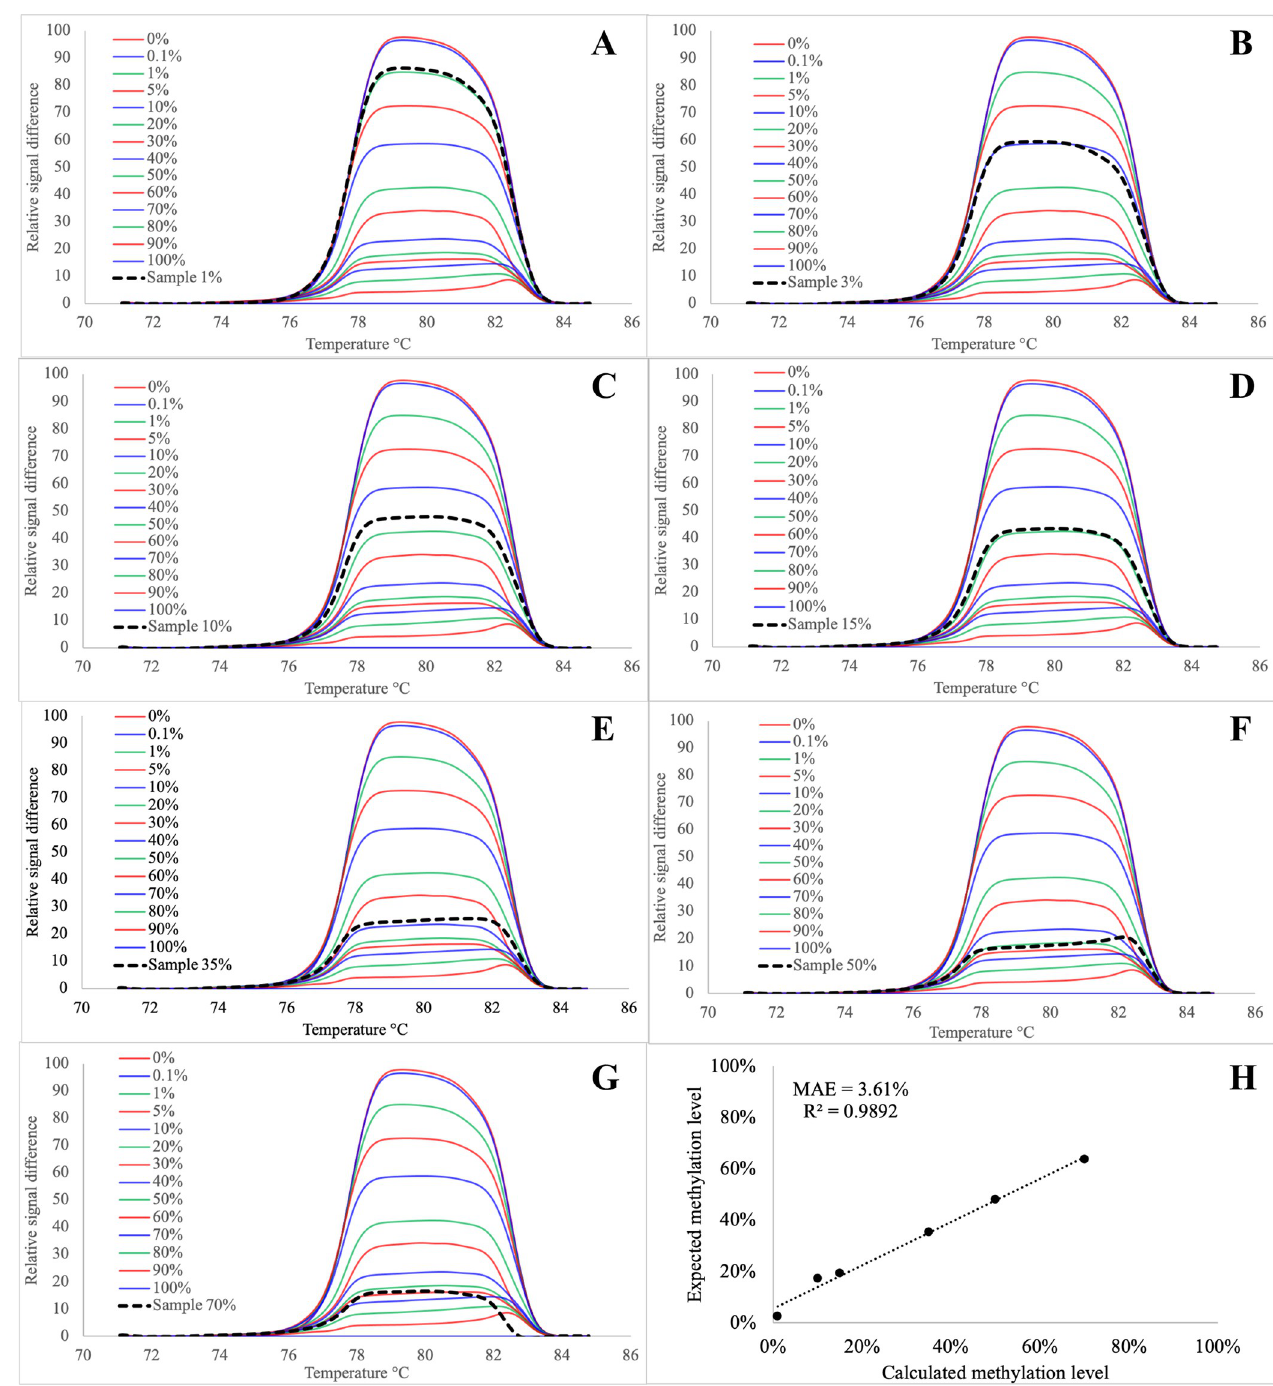
Fig 6. Example of the difference plots obtained for control mixes and constructed mixes for the EpiMelt MGMT assays with 100% methylation control as reference (panels A to F) and goodness of fit analysis for this assay (panel H). In each panel the red, blue, and green curves represent difference plots for the control mixes and black curve is a difference plot for the constructed mix of methylated template in non-methylated background (in Panel A = 1%, B = 3%, C = 10%, D = 15%, E = 35%, F = 50% and G = 70%). (H) Goodness of fit test for this assay resulted in: R 2 = 0.9892 and MAE = 3.61%. All data points were plotted as a mean of triplicate